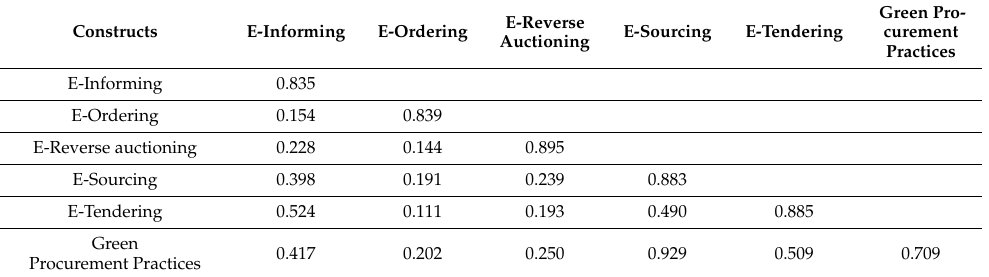
Table 5. Fornell–Larcker criterion.